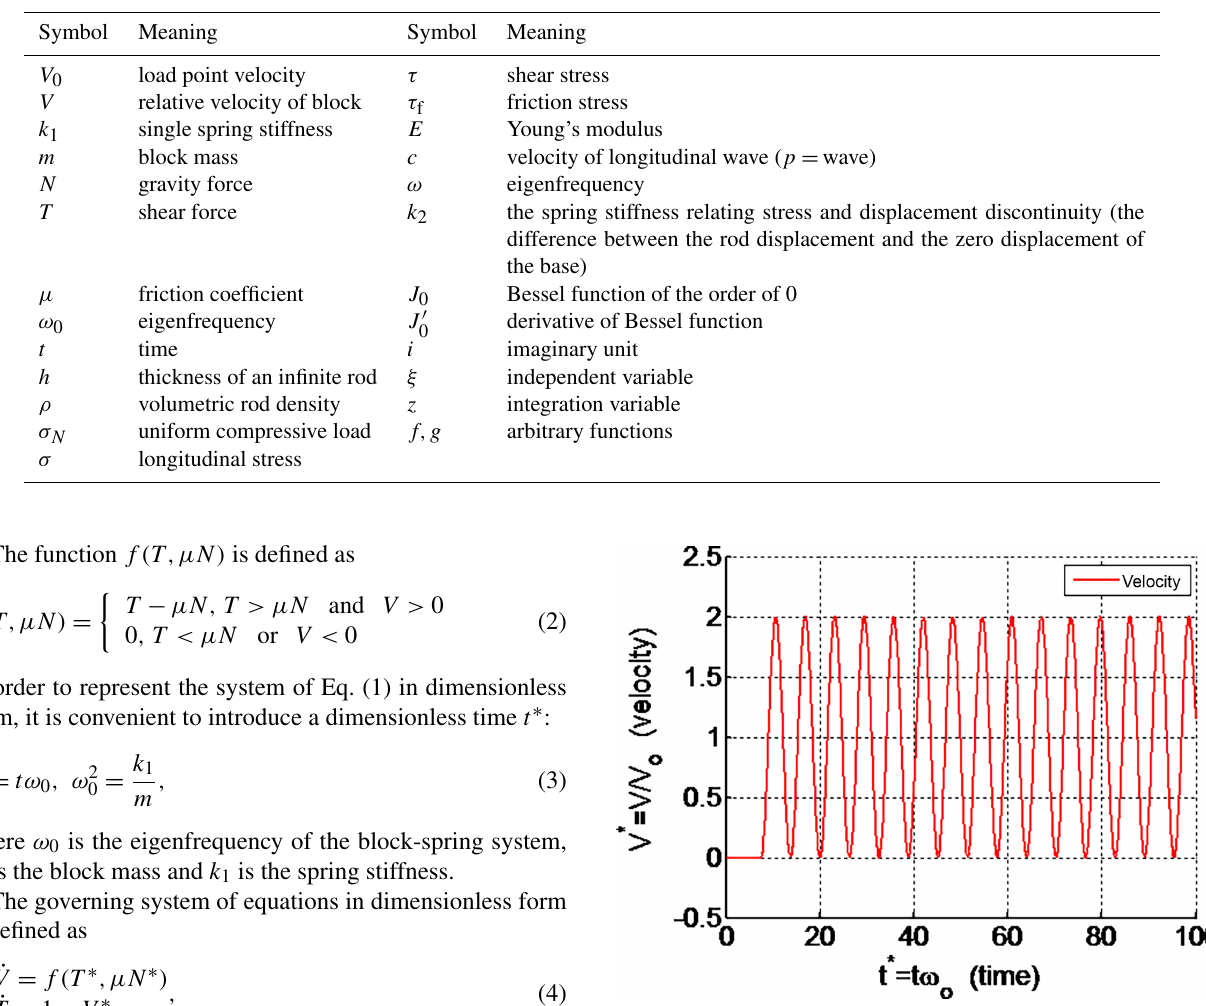
Table 1. The list of variables and constants.